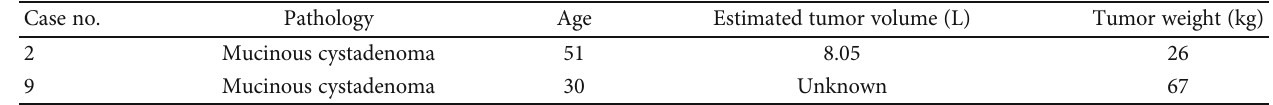
Table 2: Lists of cases with poor prognosis and major postoperative complications. (a) Cases of CPR at their fi rst hospital visit Case no.